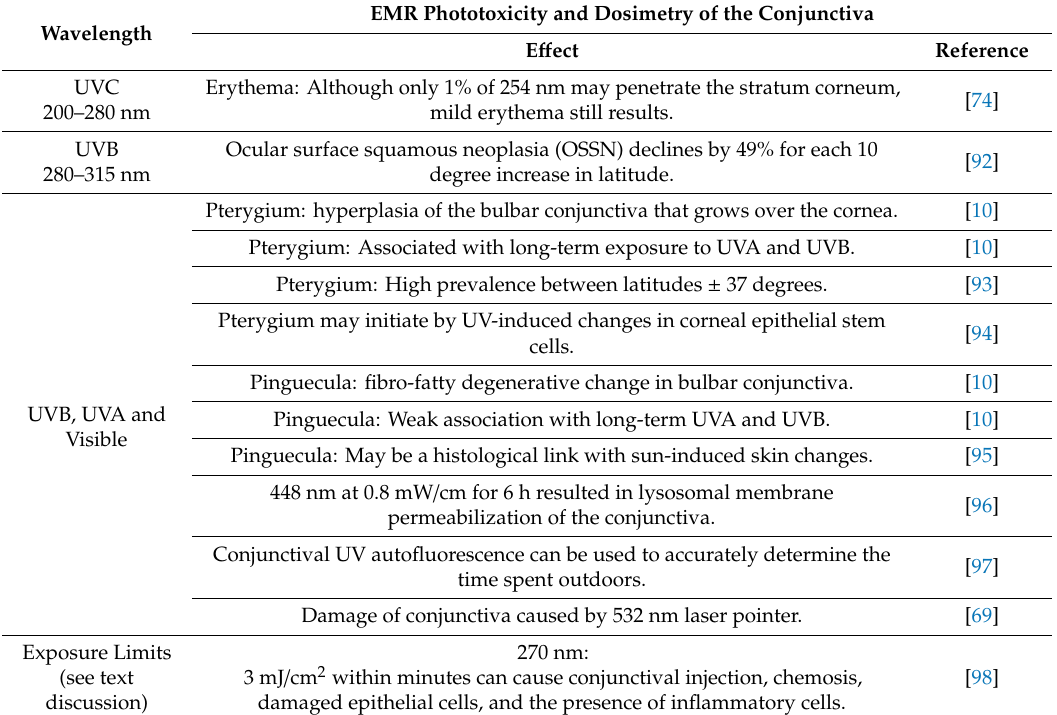
Table 3. Electromagnetic radiation action spectra and dosimetry thresholds for the